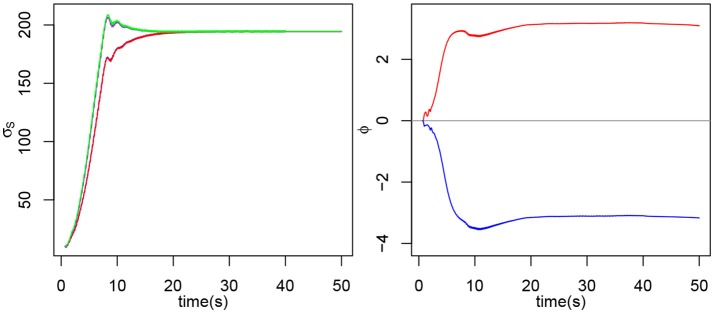
On the left, evolution of σS2E (blue), σS2F (red), σS3E (purple) and σS3F (green). Note that the two σs for each joint are completely merged, so only one is clearly visible on the plot. On the right, evolution of ϕ3E and ϕ3F during the experiment for the extensor and flexor of the second joint.